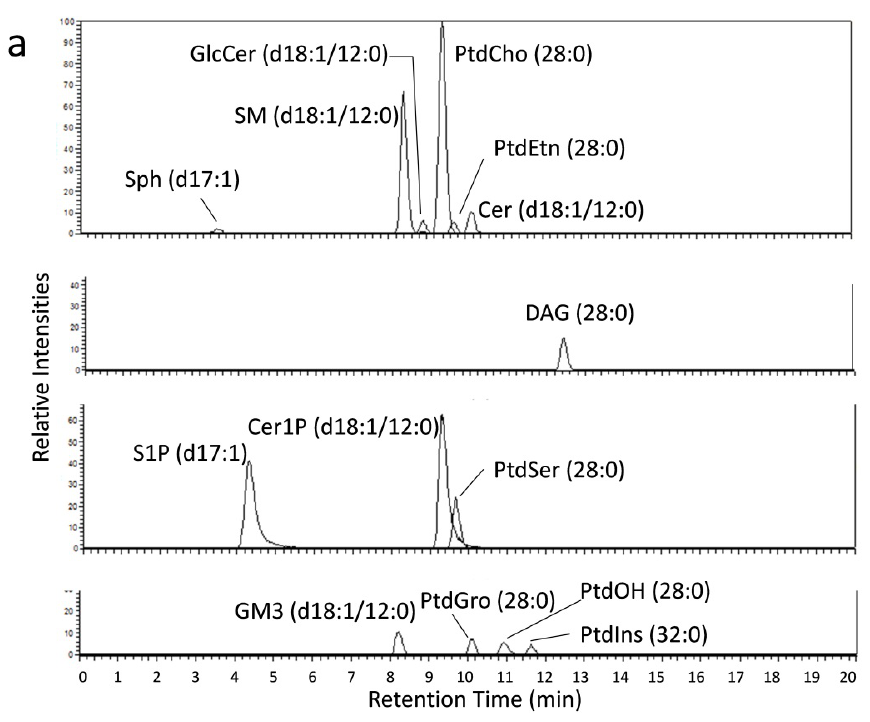
Figure 4. Mass chromatograms of the standard lipids added to the cell suspension. ( a ) 50 pmol of each synthetic standard was added to a cell suspension (1 × 10 6 cells),